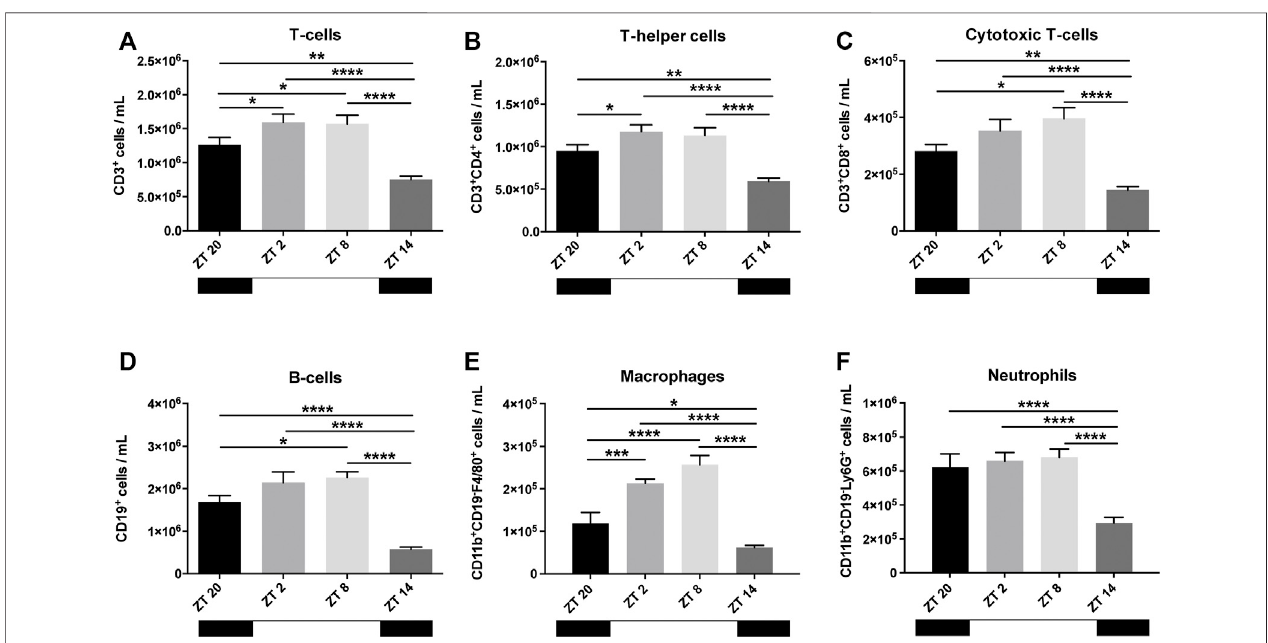
FIGURE 1 | Baseline leukocyte count in the blood. T-cells (A) , further subdivided in helper T-cells (T H -cells) (B) and cytotoxic T-cells (T C -cells) (C) showed an oscillating pattern, reaching its highest frequency at ZT2-ZT8 (T H -cells) and ZT8 (T C -cells). B-cells also had a clear oscillation, reaching highest circulatory levels at ZT2- ZT8 (D) .Macrophages (E) showedapattern similartoB-andT-cells.Neutrophilshadstablehighlevels,whichdropped atZT14 (F) ( n =10 – 12pergroupforallanalysis) ( *p < 0.05, **p < 0.01, ***p < 0.001, and ****p < 0.0001 by one-way ANOVA with LSD